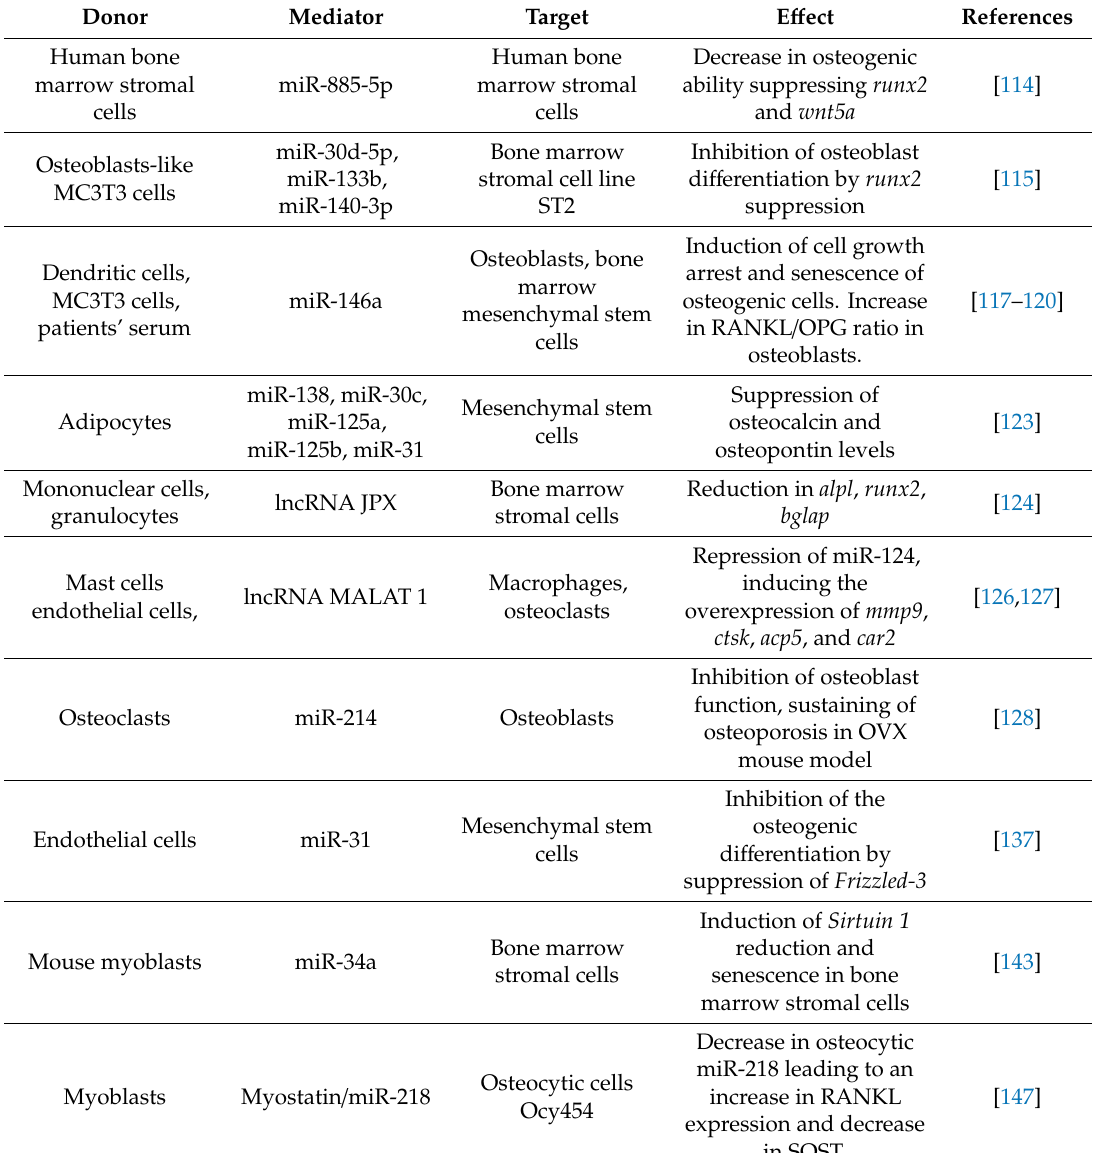
Table 1. Intercellular exchange of miRNAs and their osteopenic e ff